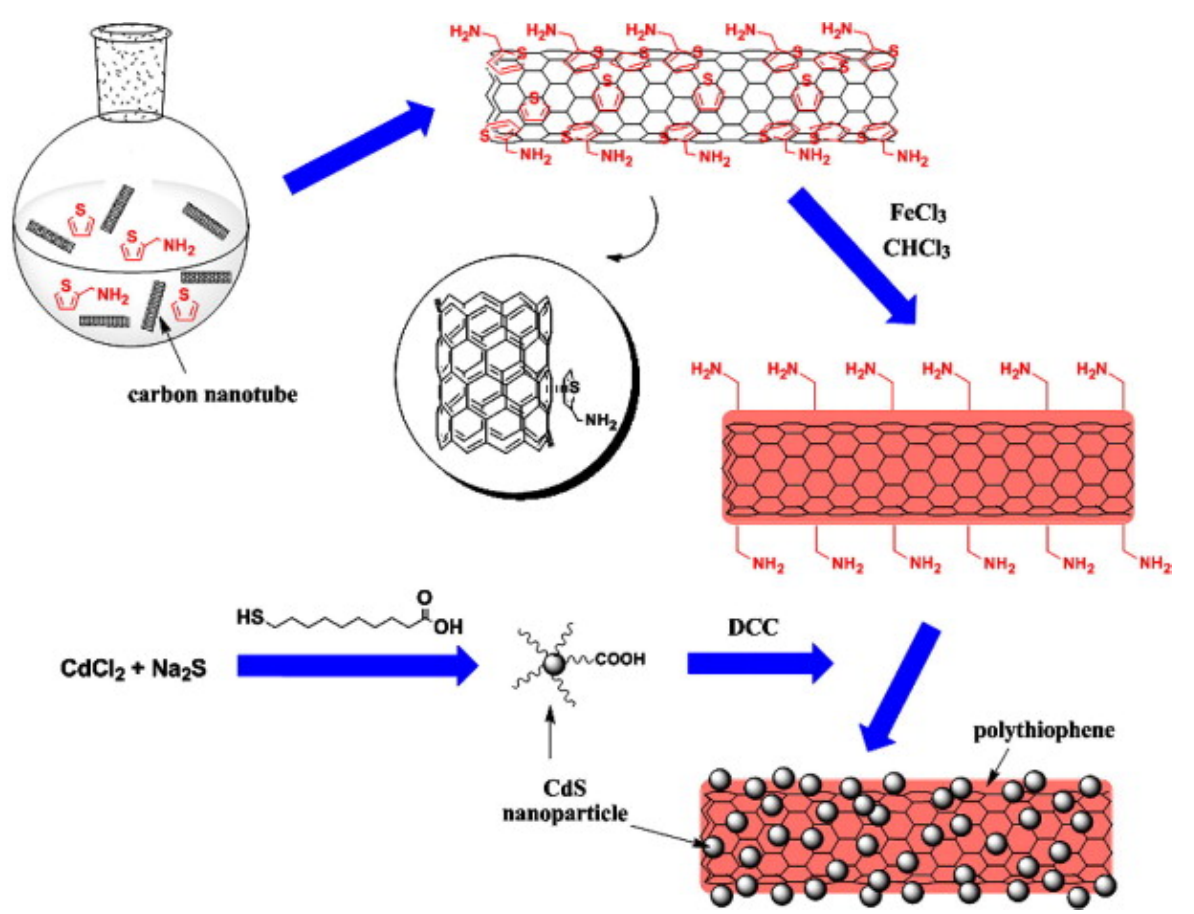
Figure 2. Schematic representation of decorating multiwalled carbon nanotubes with cadmium sulfide nanoparticles using in situ polymerized PTh serving as an inter-linker. (Reprinted with permission from [28]. Copyright 2010, Feng et).